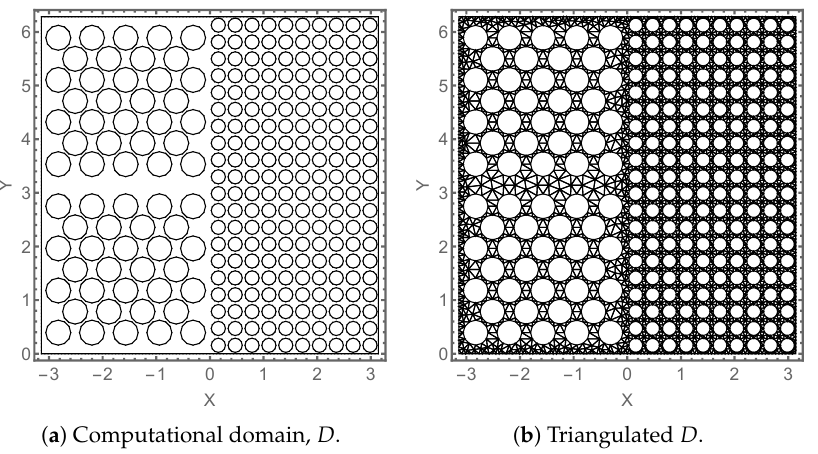
Figure 2. Trommel design: Shell of revolution with φ ( x ) = 1, i.e., uniform radius = 1. Hole coverage is 55%. The boundaries at x = ± π are clamped, holes are free, and y = 0 and y = 2 π are periodic.